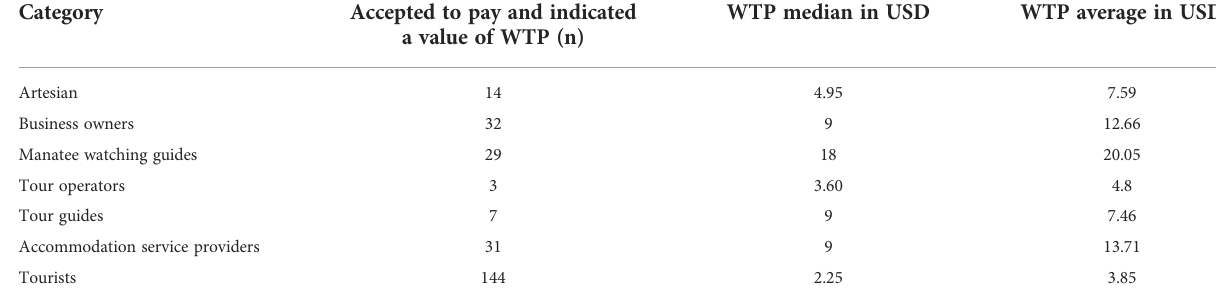
TABLE 3 Willingness to pay (WTP) for West Indian manatee conservation according to interviewed categories. Category Accepted to pay and indicated a value of WTP